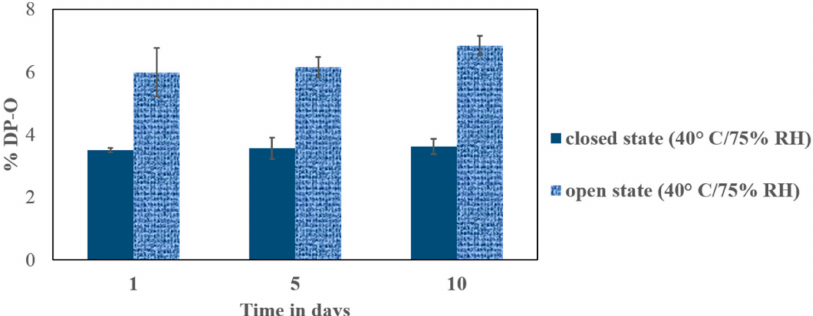
Figure 6. The bar plots representing the percent oxidative degradation in the closed (solid bars) and open (patterned bars) storage at di ff erent time intervals. The vertical lines denote the SD for the replicate sample analysis ( n =